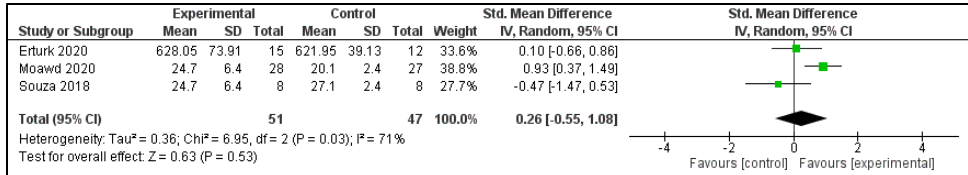
Figure 7. Forest plot for physical capacity.